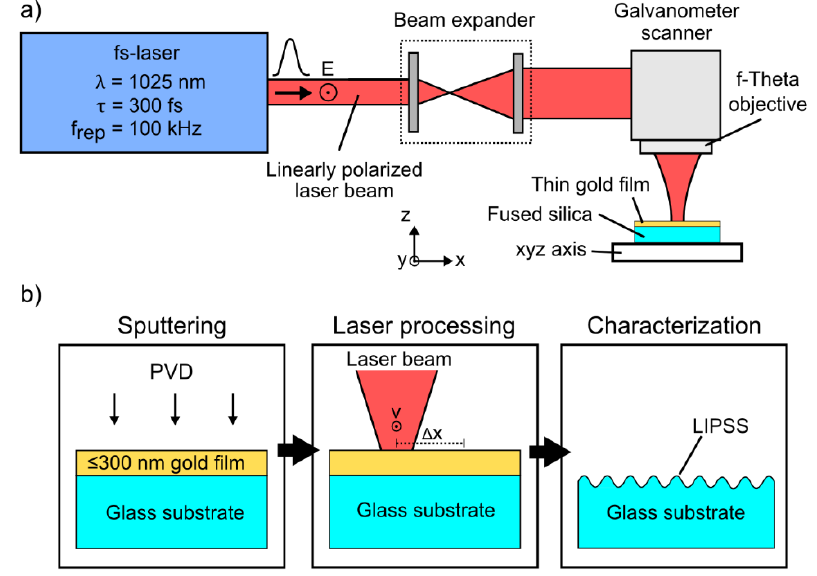
Figure 1. ( a ) Scheme of the experimental setup used for the generation of laser-induced periodic surface structures (LIPSS) on fused silica and ( b ) processing steps required for the large-area structuring with